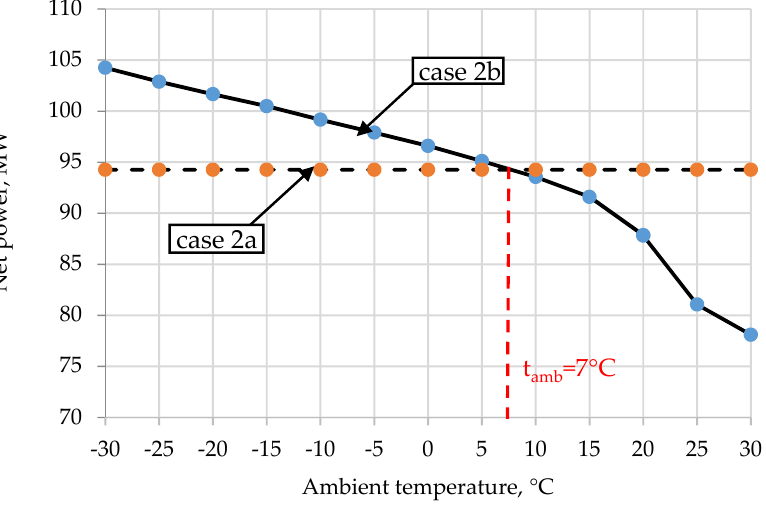
Figure 7. Diagram for the choice of TPPs with BPSTs modification type.